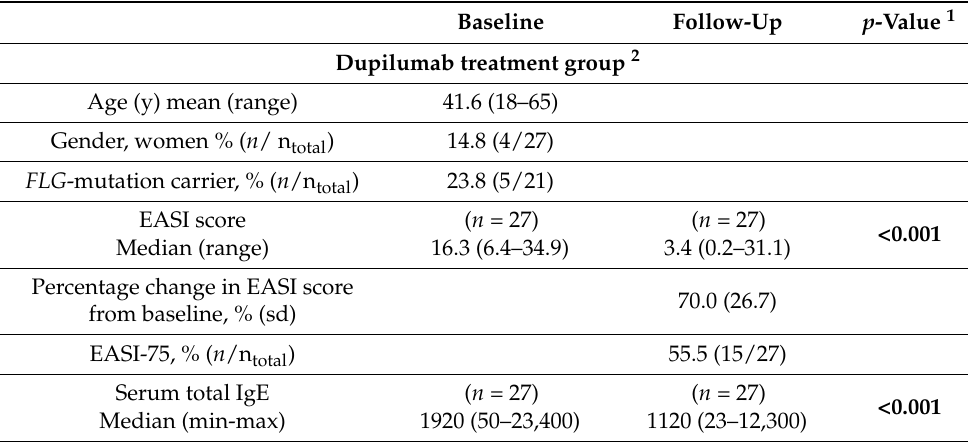
Table 1. Demographic and clinical parameters at baseline and following treatment in the two treatment